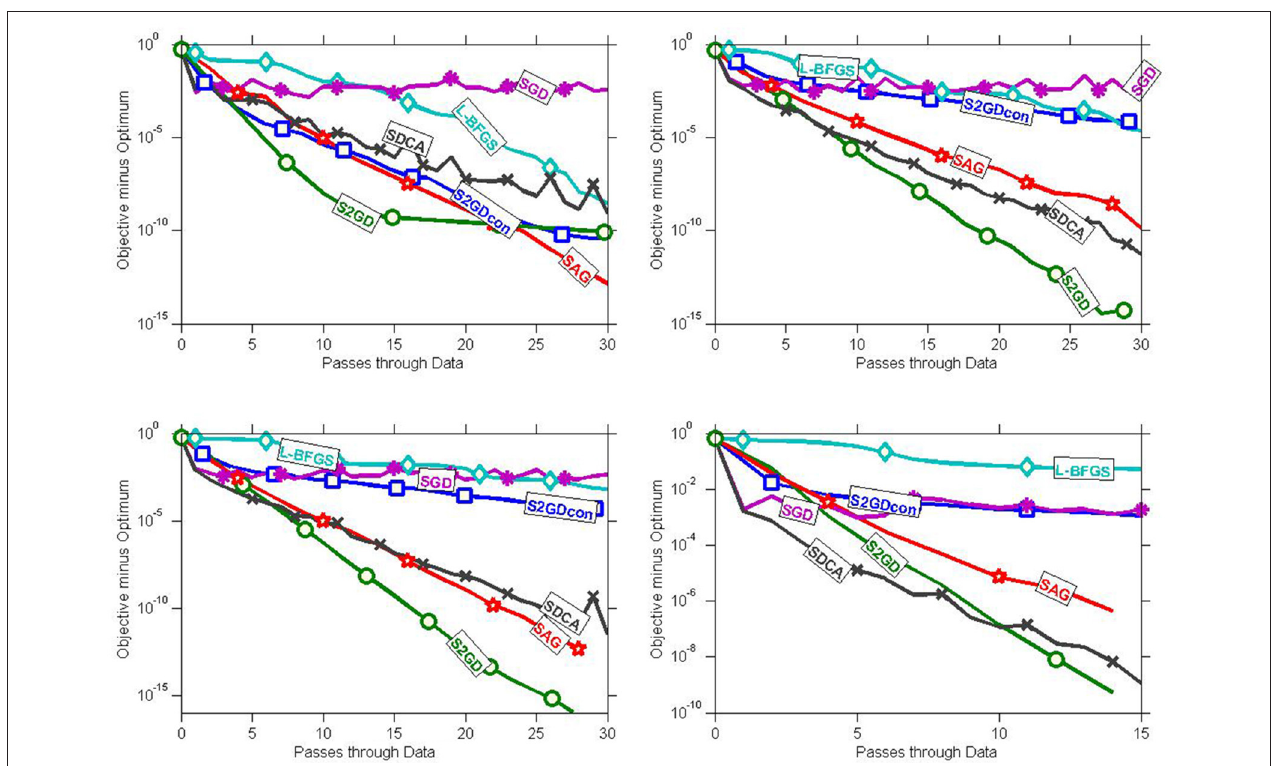
FIGURE 2 | Practical performance for logistic regression and the following datasets: ijcnn, rcv (first row), realsim, url (second row).